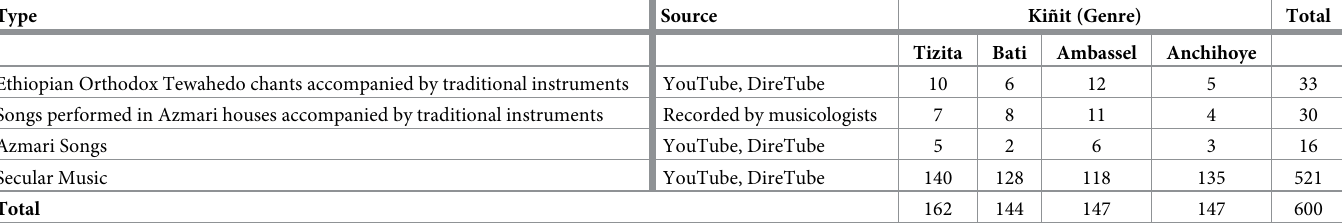
Table 1. Breakdown of the EMIR